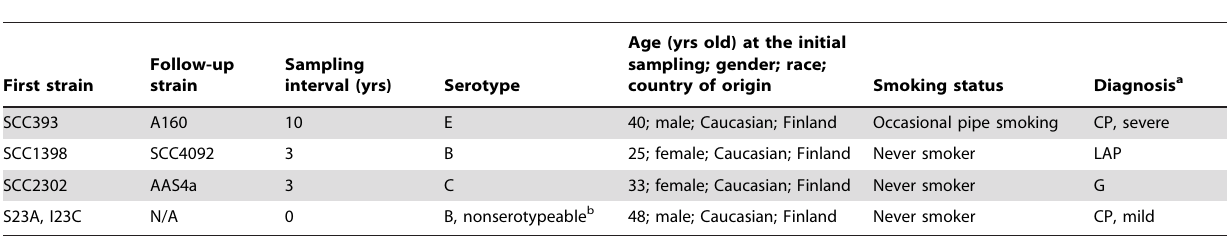
Table 1. Four sets of paired strains of A. actinomycetemcomitans recovered from four individuals.